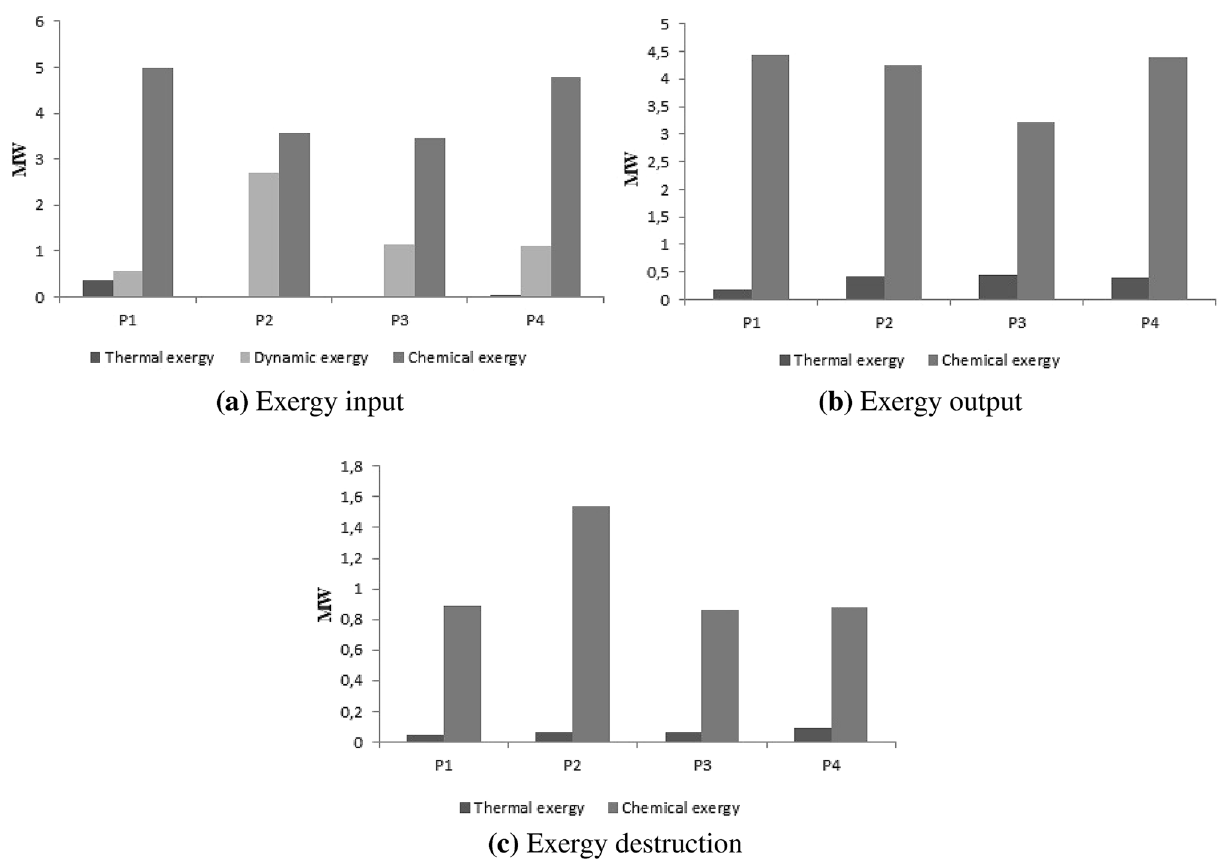
Fig. 2 Qualitative exergy